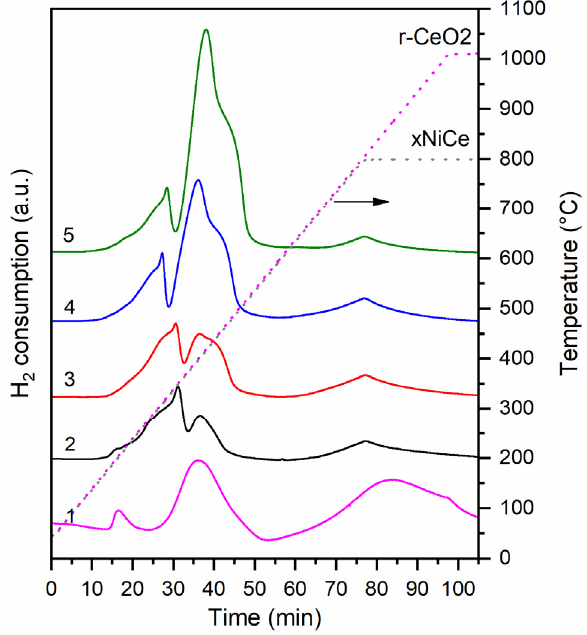
Figure 2. H 2 -temperature programmed reduction (H 2 -TPR) profiles of samples: (1) r-CeO 2 ; (2) 2NiCe ; (3) 4NiCe ; (4) 8NiCe ; (5) 12NiCe.